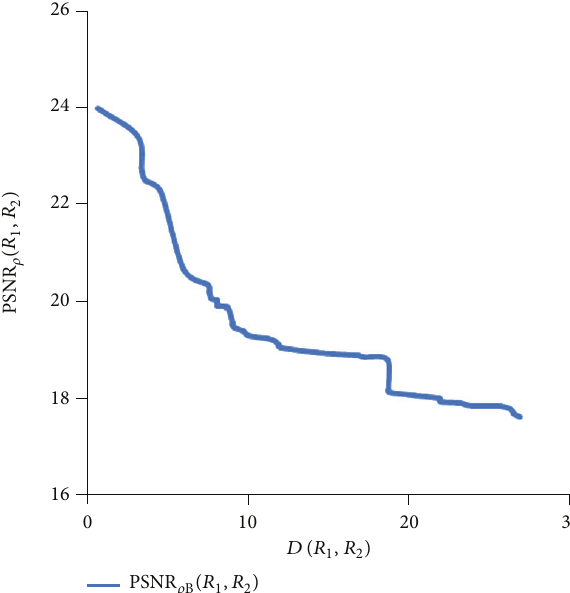
Figure 7: Trend of PSNR with respect to distance (18) for the pen obtained from the comparison with the sample image at 𝜃 = 10 ∘ and 𝜙 = 54 ∘ .